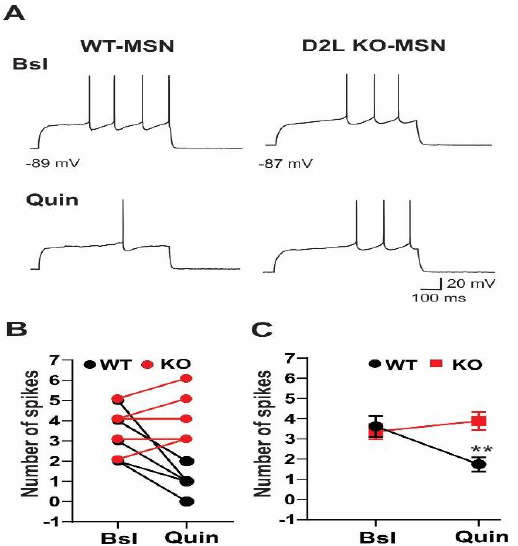
Figure 2. Effect of quinpirole on spike firing of MSNs was absent in D2L KO mice. ( A ) Baseline (Bsl) spikes were induced by injecting depolarizing currents in MSNs from WT and D2L KO mice (top traces). Quinpirole (Quin) significantly decreased the firing rate in MSNs from WT mice (left middle trace), but it had no effect on the firing rate in MSNs from D2L KO mice (right middle trace). ( B ) Summary of quinpirole effects on spike firing of MSNs from WT mice (filled black circles, n = 7) and from D2L KO mice (filled red circles, n = 8). The spike numbers of individual cells were plotted versus Bsl (without quin) or in the presence of Quin. ( C ) The mean spike numbers were plotted versus Bsl or Quin. ** p < 0.002 (WT); p > 0.3 (D2L KO). Furthermore, quinpirole suppressed the spike firing in FSIs in both WT and D2L KO mice (WT: Bsl: 5.52 ± 0.42 Hz, Quin: 2.00 ± 0.57 Hz, n = 6; p < 0.001; D2L KO: Bsl: 4.14 ± 0.40